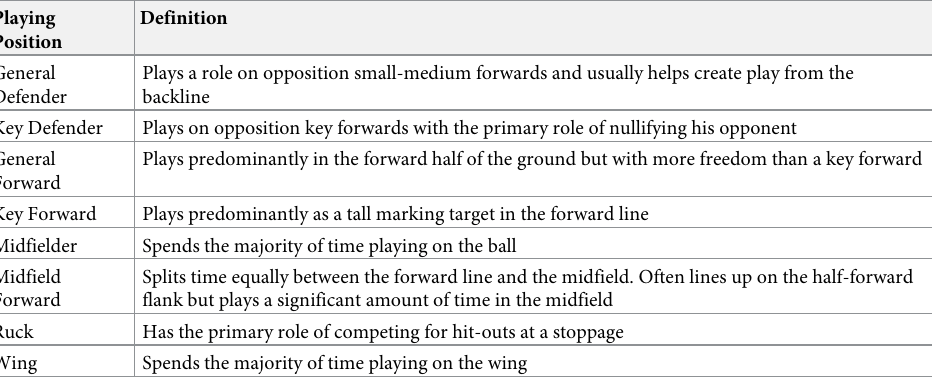
Table 1. Champions data’s descriptions of the seven player roles used in this